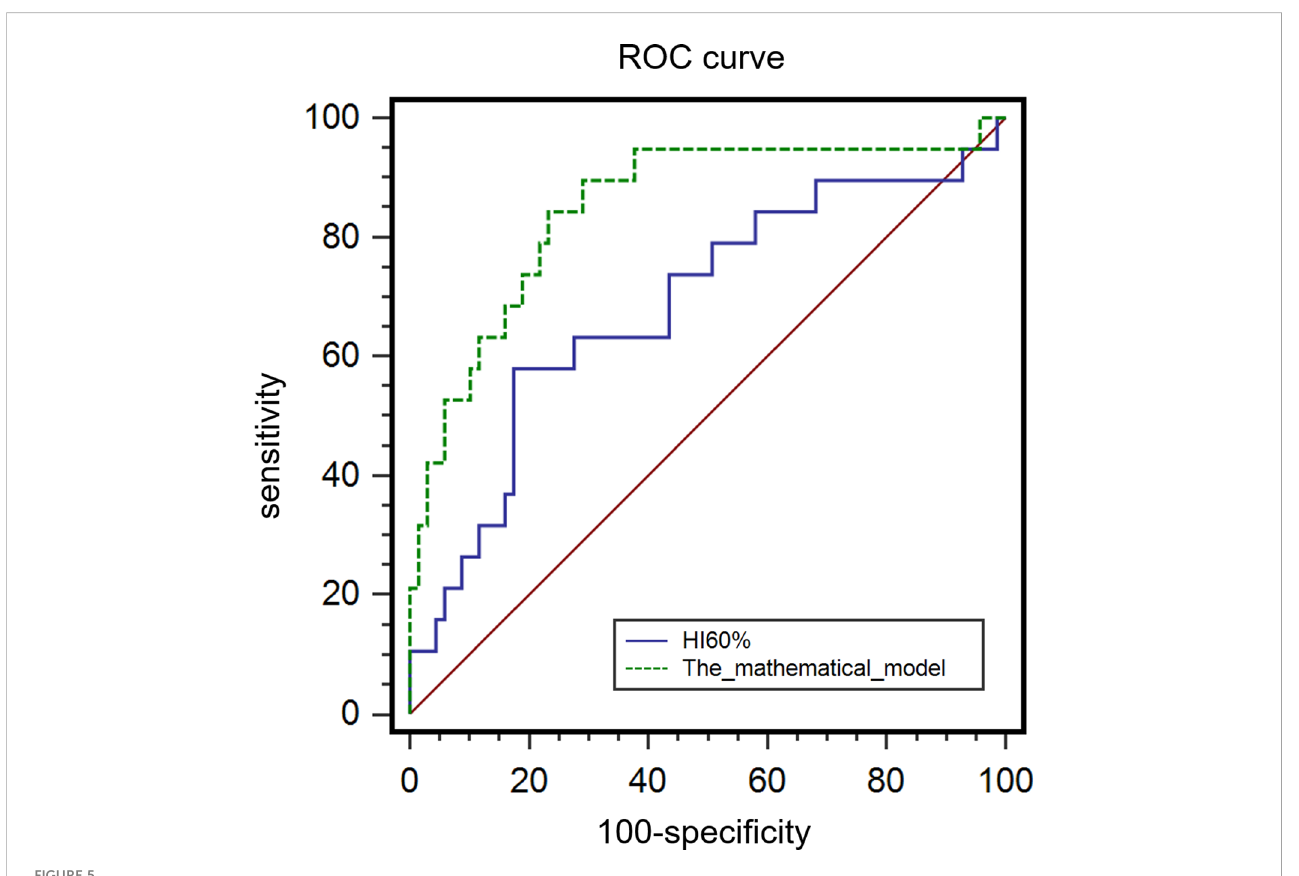
FIGURE 5 ROC curve for HI 60% and the mathematical model in predicting MSI.